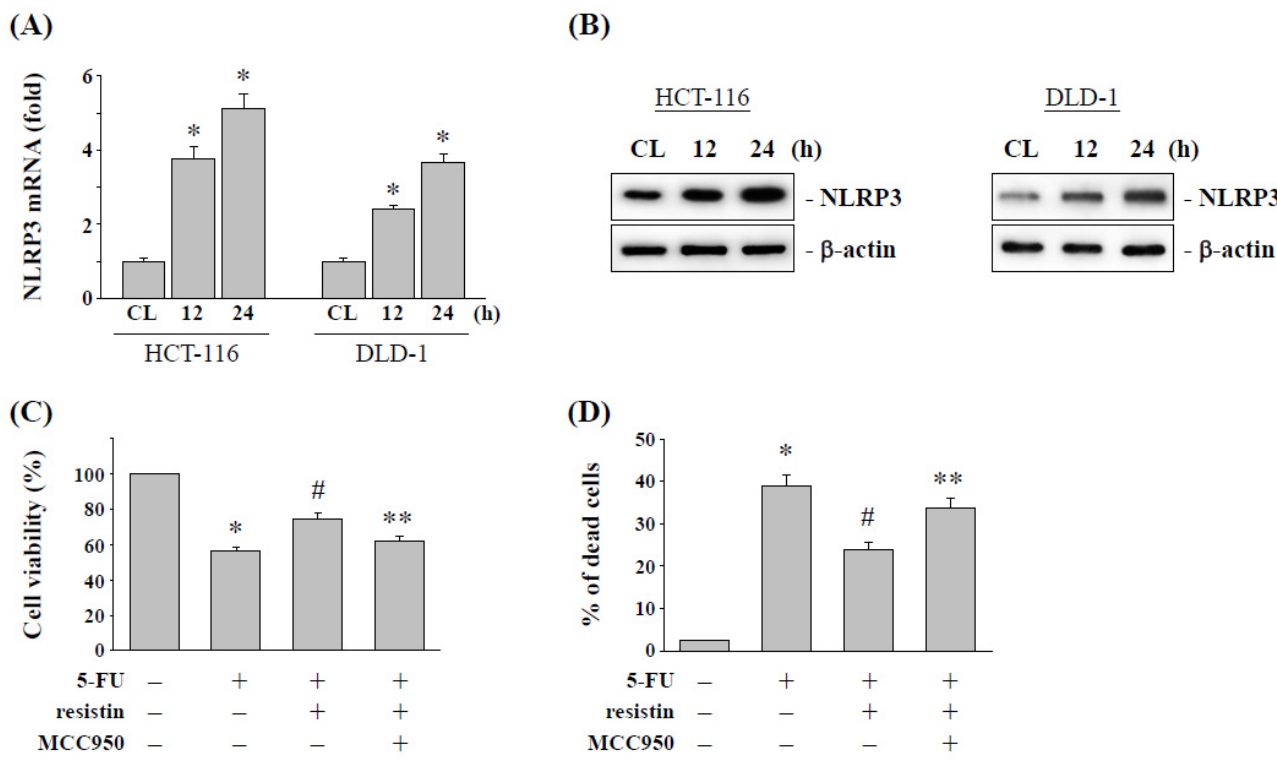
Figure 3. Inhibition of NLRP3 expression in CRC cells enhances the cytotoxicity induced by 5- FU. HCT-116 and DLD-1 cells were kept as the control (CL) or treated with resistin (50 ng/mL) for the indicated times. The mRNA ( A ) and protein ( B ) expression of NLRP3 were determined by real-time PCR and Western blotting, respectively. Data in ( A ) are shown as mean ± SEM from three independent experiments. * p < 0.05 versus CL. Results in ( B ) are representative of three independent experiments with similar results. ( C , D ) HCT-116 cells were kept as the control (CL) or treated with resistin for 12 h, then cultured in 5-FU for a further 48 h. After being treated with resistin, HCT-116 cells were pretreated with a specific inhibitor for NLRP3 (MCC950) and then treated with 5-FU (5 µ M). ( C ) HCT-116 cell viability was assayed by the MTS assay. ( D ) HCT-116 cells were collected and stained with trypan blue dye, and the number of dead cells was manually counted. The percentage of trypan blue-positive cells represent the population of dead cells. Data represent the mean ± SEM from three independent experiments; * p < 0.05 vs. cells without treatment. # p < 0.05 vs. cells treated with 5-FU; ** p < 0.05 vs. cells treated with resistin and 5-FU.